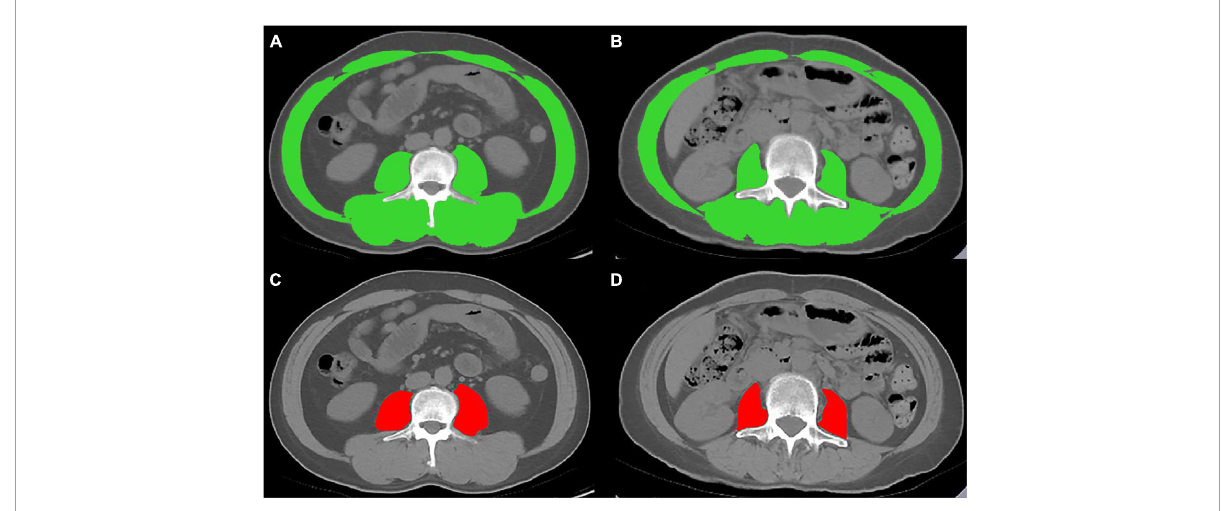
FIGURE1 Cross-sectional computed tomographic images at the third lumbar vertebrae level. The skeletal muscle area (SMA) was measured by manual tracing in (A) male and (B) female. The psoas muscle area (PMA) was measured by manual tracing in (C) male and (D) female.